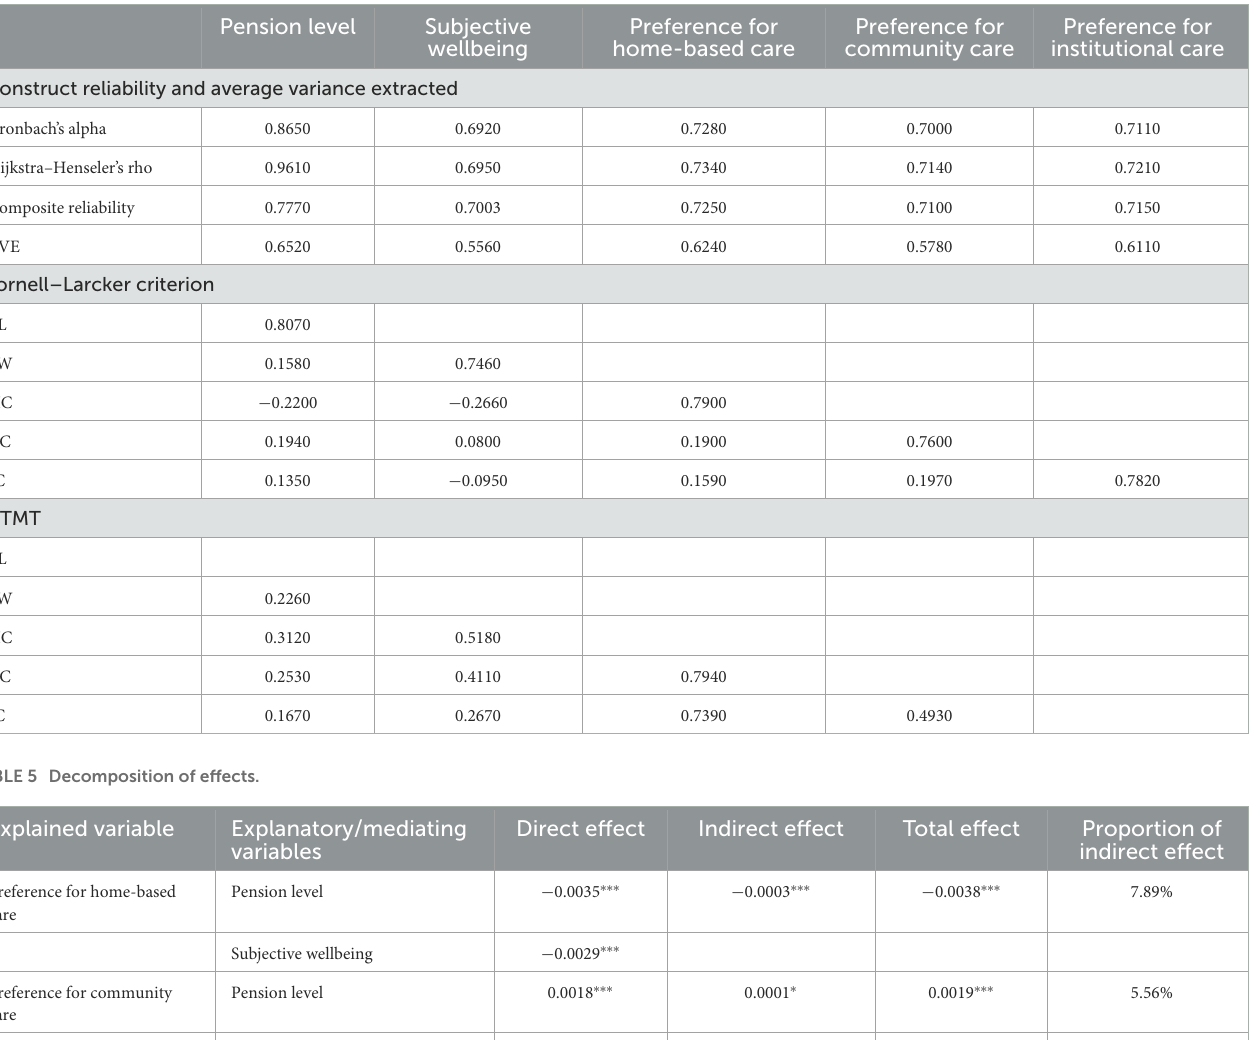
TABLE 4 Measurement model evaluation.